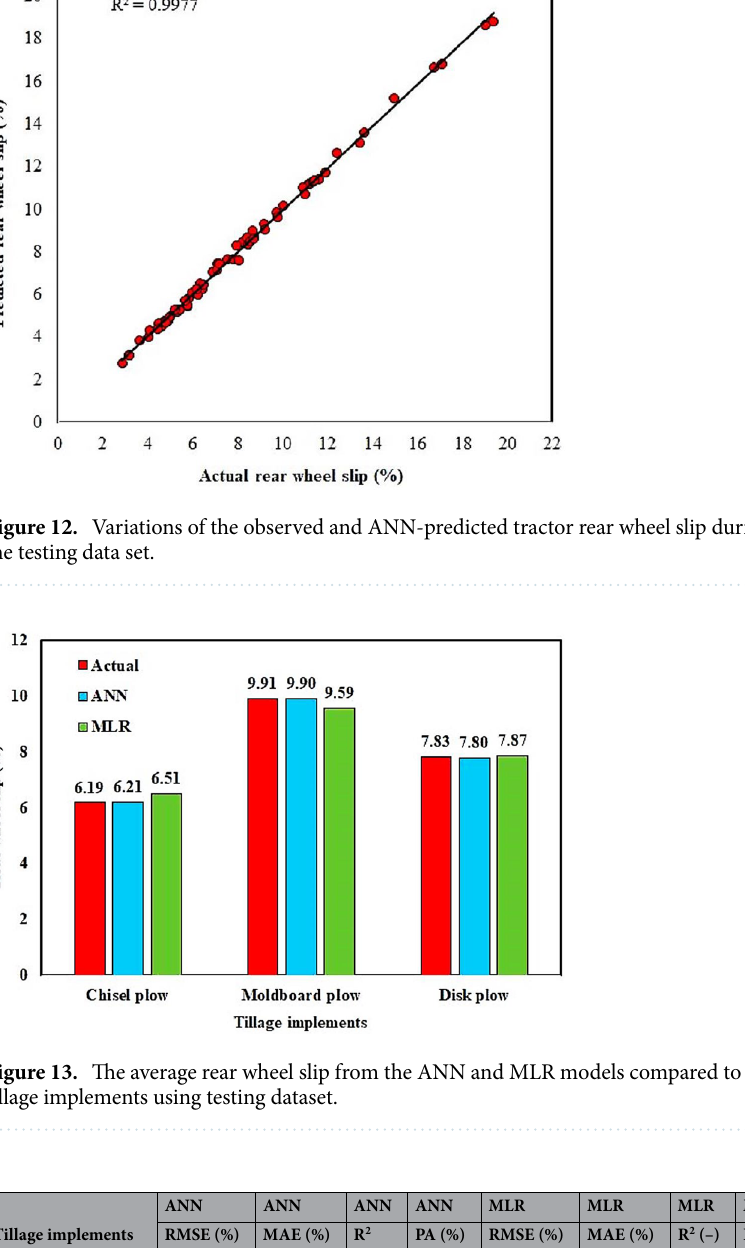
ANN ANN ANN Tillage implements